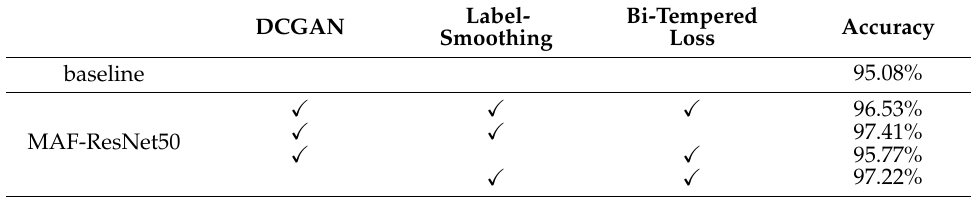
Table 5. Ablation experiment result of other